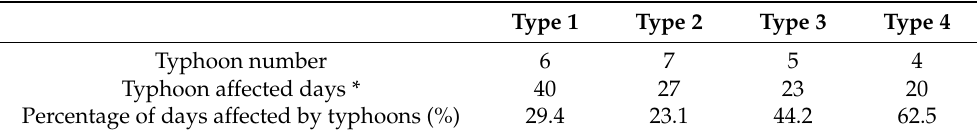
Table 3. Typhoon statistics under the four synoptic types in 2015 (July, August) and 2016 – 2018 (June, July, August).